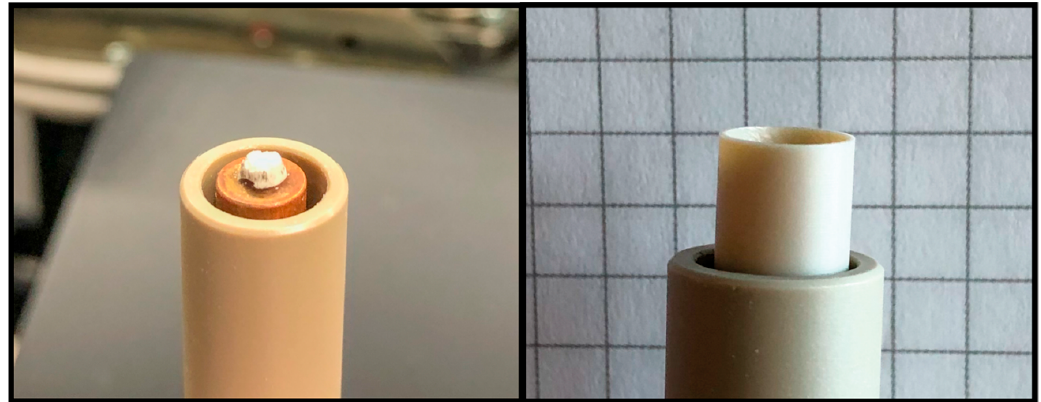
Figure 3. Left : Particle sample on the sample holder; Right : Cylindrical cup-attachment for packed Figure 3. Left: Particle sample on the sample holder; Right: Cylindrical cup-attachment for packed beds and beds and liquids.